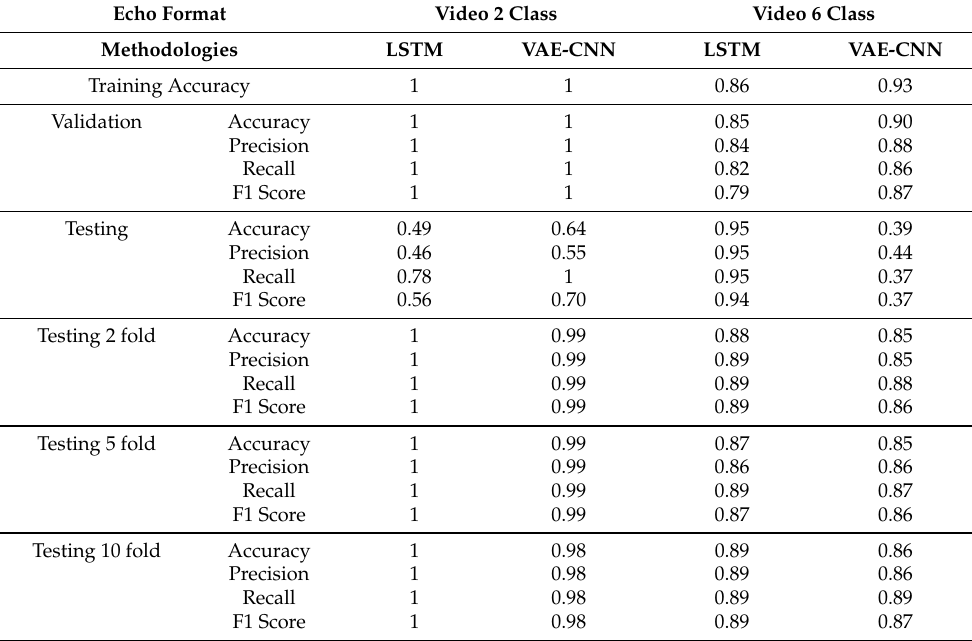
Table 6. Output for Video 2 (normal or abnormal) and six-class (types of